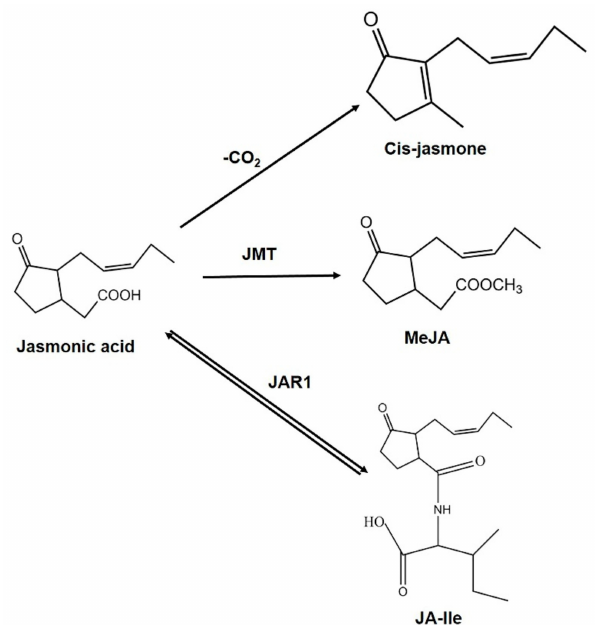
Figure 3. Major bioactive jasmonates in plants and their bioconversion. -CO 2 , decar-boxylation; JMT, jasmonic acid carboxyl methyltransferase; MeJA, methyl jasmonate; JAR1, jasmonate amino acid synthetase 1; JA-Ile, jasmonyl